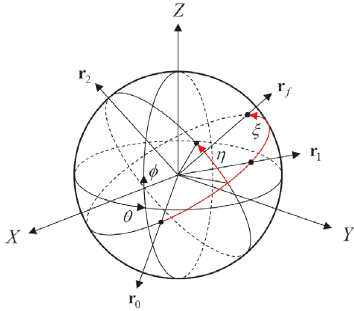
Figure 2: Relationship between feasible solutions and weighing parameter. Figure 3: (𝜙,𝜃) polar coordinate system and (𝜉,𝜂) coordinate